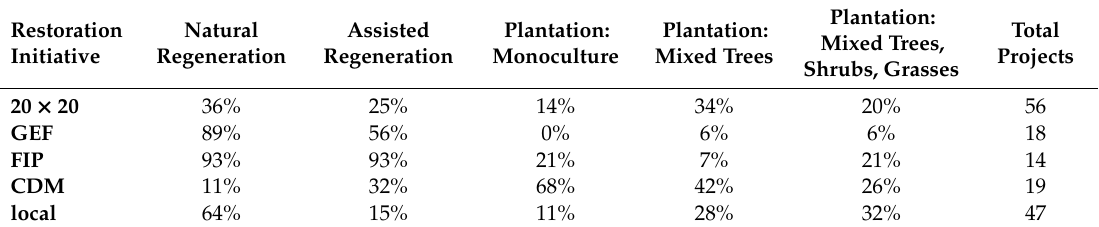
Table 5. Sub-activities under “Restoration of vegetation in terrestrial systems”, summarized by restoration initiative. Note: one restoration project can have multiple restorative